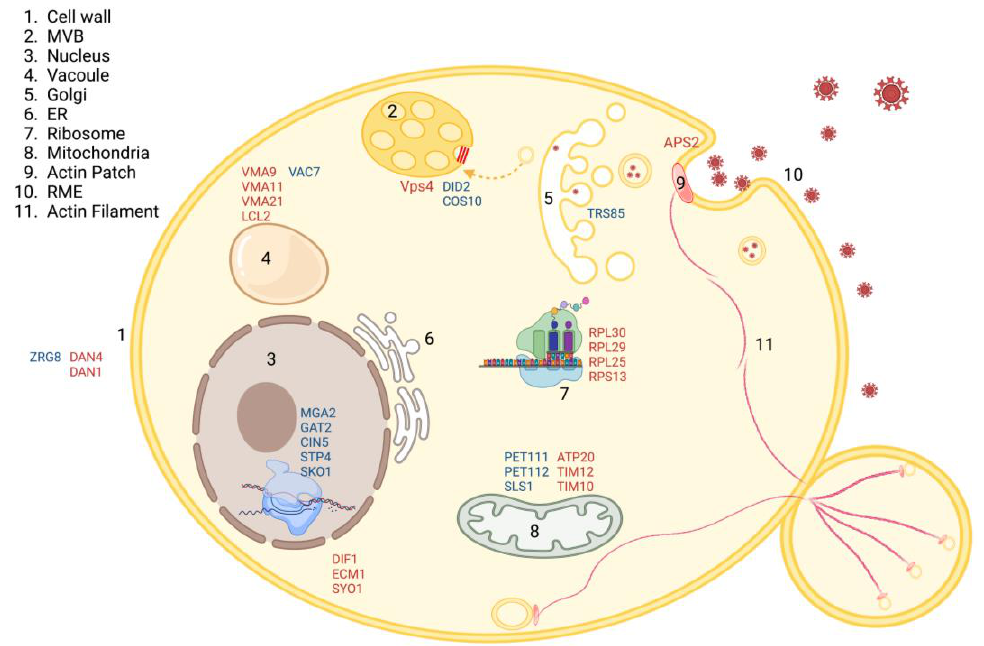
Figure 8. Model of important upregulated genes (blue) and downregulated genes (red) upon CdSe/ZnS QDs treatment, as shown by RNA-seq data. Upregulated genes include genes associated with the mitochondria structure and function (PET111, PET112, and SLS1), genes involved in the vesicular trafficking (DID2, COS10, and TRS85), a gene involved in cell wall integrity (ZRG8), transcription regulation (MGA2), and vacuole structure (VAC7). Important downregulated genes include genes involved in translation (RPL30, RPL29, RPL25, and RPS13), mitochondria and metabolism-related genes (ATP20, TIM12, and TIM10), transcription factor genes (GAT2, CIN5, STP4, and SKO1), cell wall integrity genes (DAN1 and DAN4), endocytosis regulation gene (APS2), and vacuole-associated genes (VMA9, VMA11, VMA21, and LCL2). Created with BioRender.com . Among the upregulated genes, DID2 is the gene with the highest fold change (82.3, p -value is 0.025) (Table 5). Did2 is a key regulator of the endosomal sorting complex